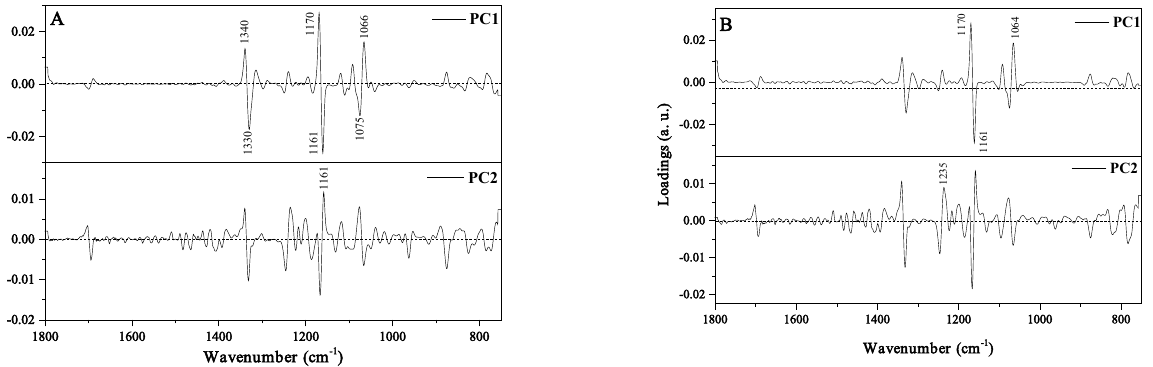
Figure 4. The loading plot of PC1 (on the top) and PC2 (on the bottom) for the region 750–1800 cm − 1 . ( A )—analysis conducted for 14 samples (I-V group) and ( B )—analysis conducted for 11 samples (II–V